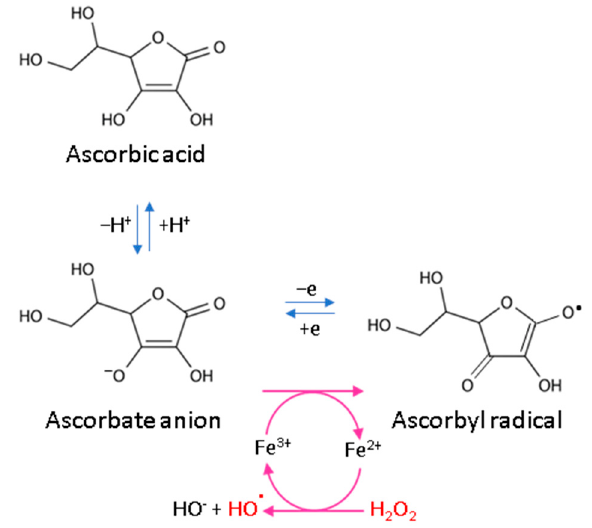
Figure 3. Scheme of ascorbic acid reaction under oxidative